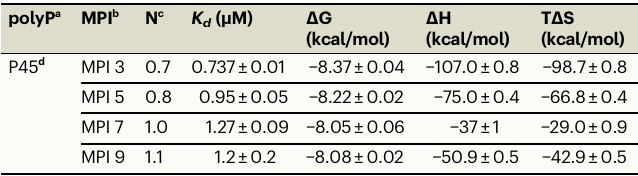
Table 2 | Summary of ITC data characterizing the thermo- dynamic properties, stoichiometry (N) and equilibrium dis- sociation constant K d for binding of MPI to polyP at pH 7.4 and 25